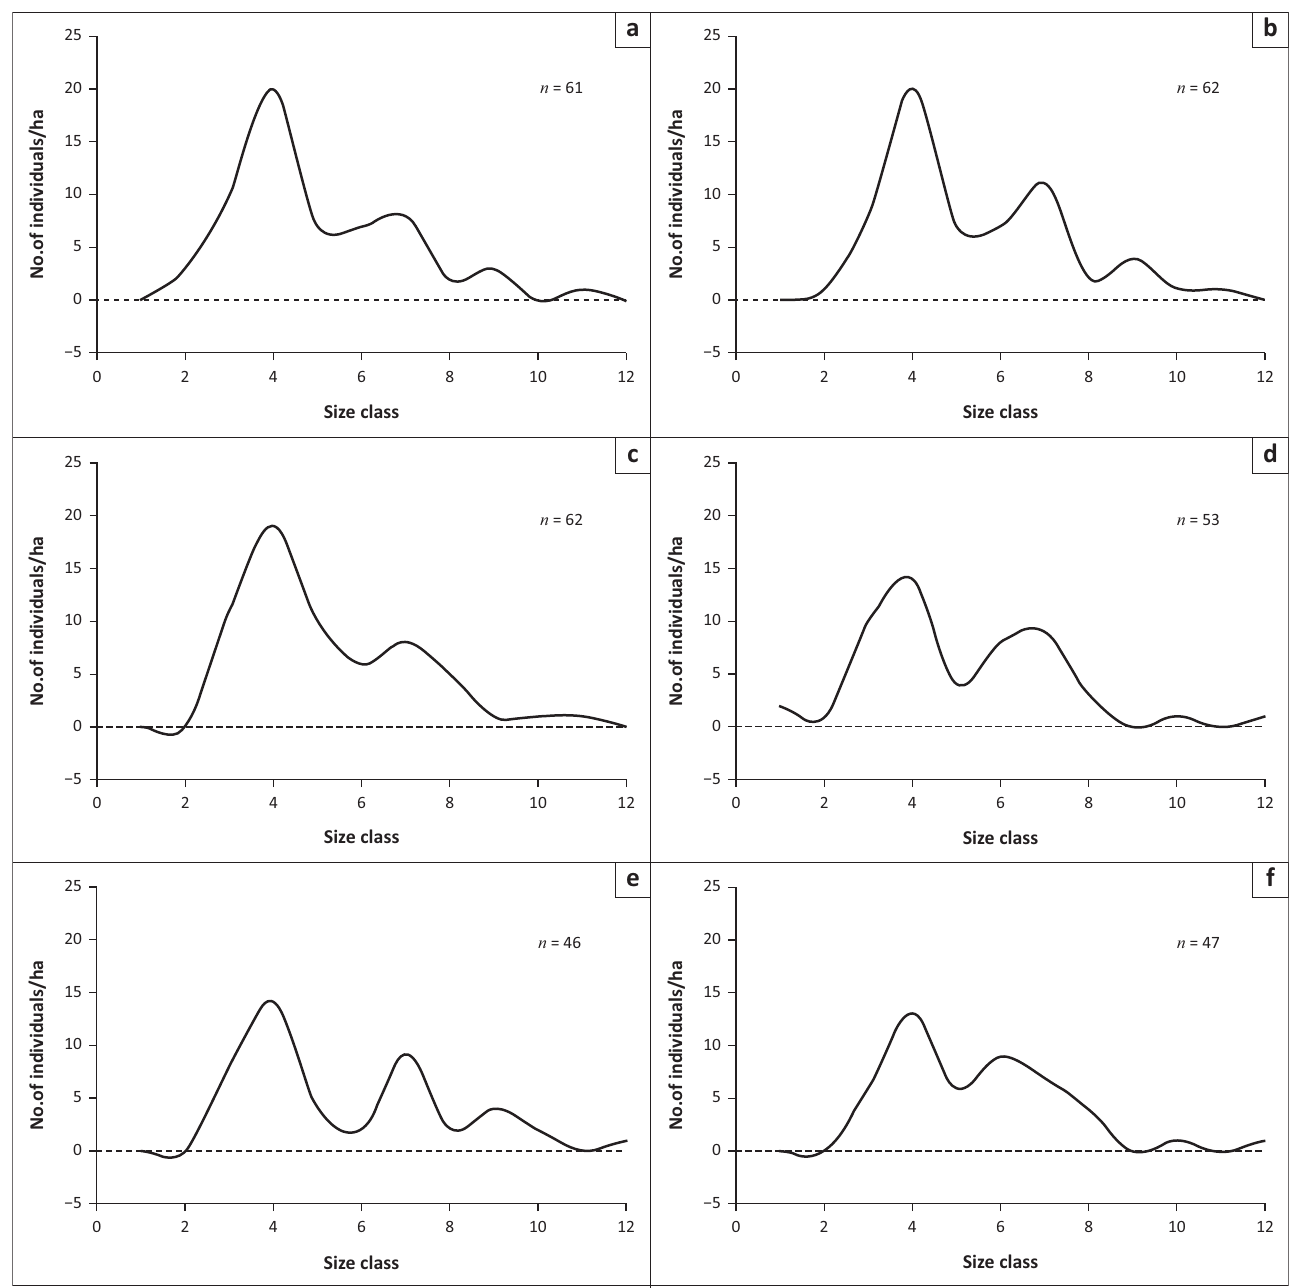
FIGURE 5: Size class distribution curves of Vachellia erioloba individuals at the Grootkolk site in the various survey years. (a) 1986; (b) 1984; (c) 1986; (d) 1989; (e) 1994; (f) 1996; (g) 1999; (g) 2008; (i)